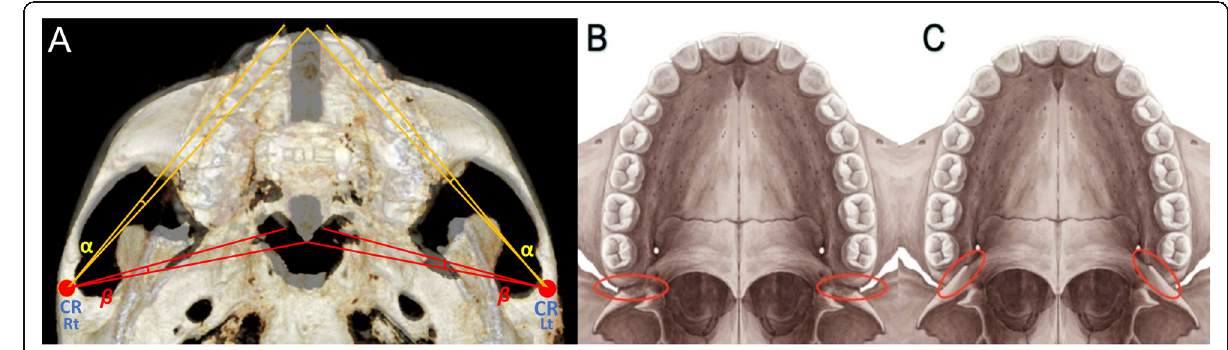
Fig. 10 a Superimposition of the two images, before and after expansion, illustrating the rotational movement around the center of rotation (CR), near the posterior zygomatic arch. The α value represents the degree of rotation between pre- and post-ANS positions. The β value represents the degree of rotation between pre- and post-PNS positions. b The pterygopalatine suture oriented relatively parallel to maxillary movement. c The pterygopalatine suture is not parallel to maxillary